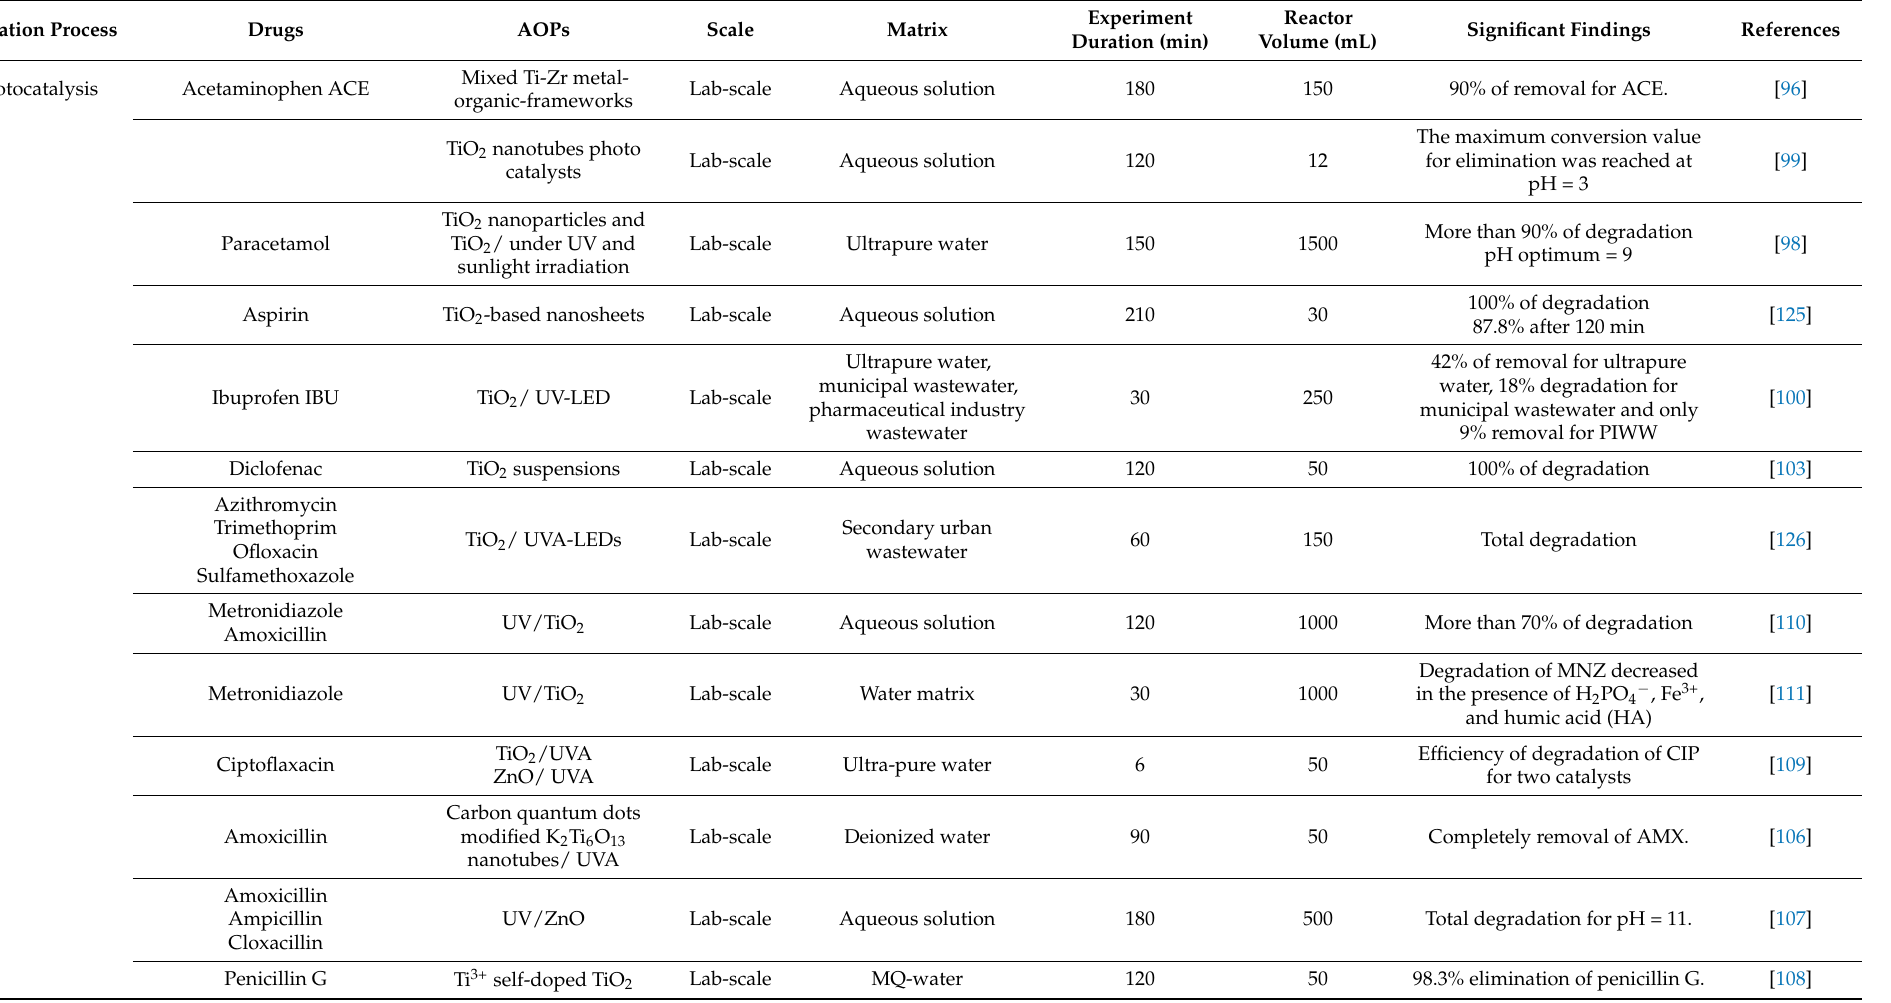
Table 3. Removal of different pharmaceutical products by